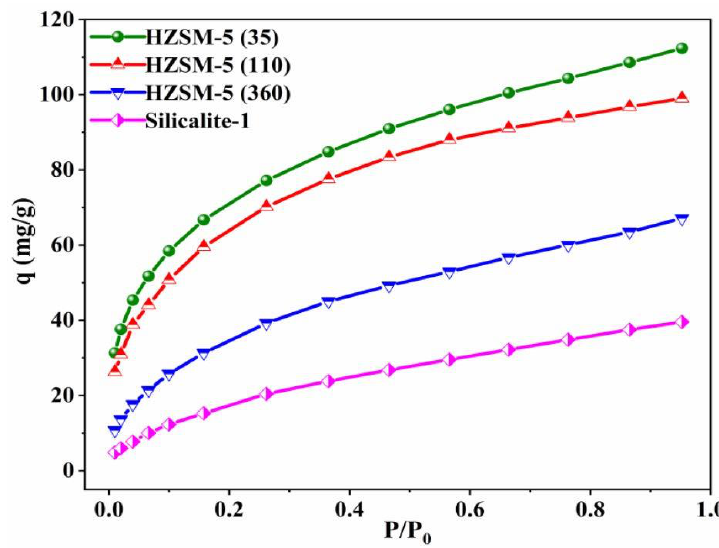
Figure 5. Water vapor adsorption isotherms on all samples at 25 °C .